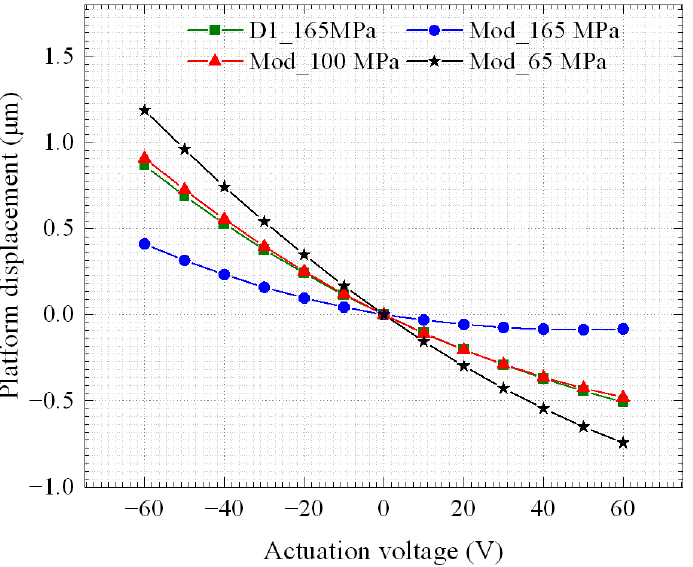
Figure 12. Out-of-plane displacement of the platform of the modified (Mod) version, including optical waveguides with different residual stresses compared to the fabricated devices (D1).